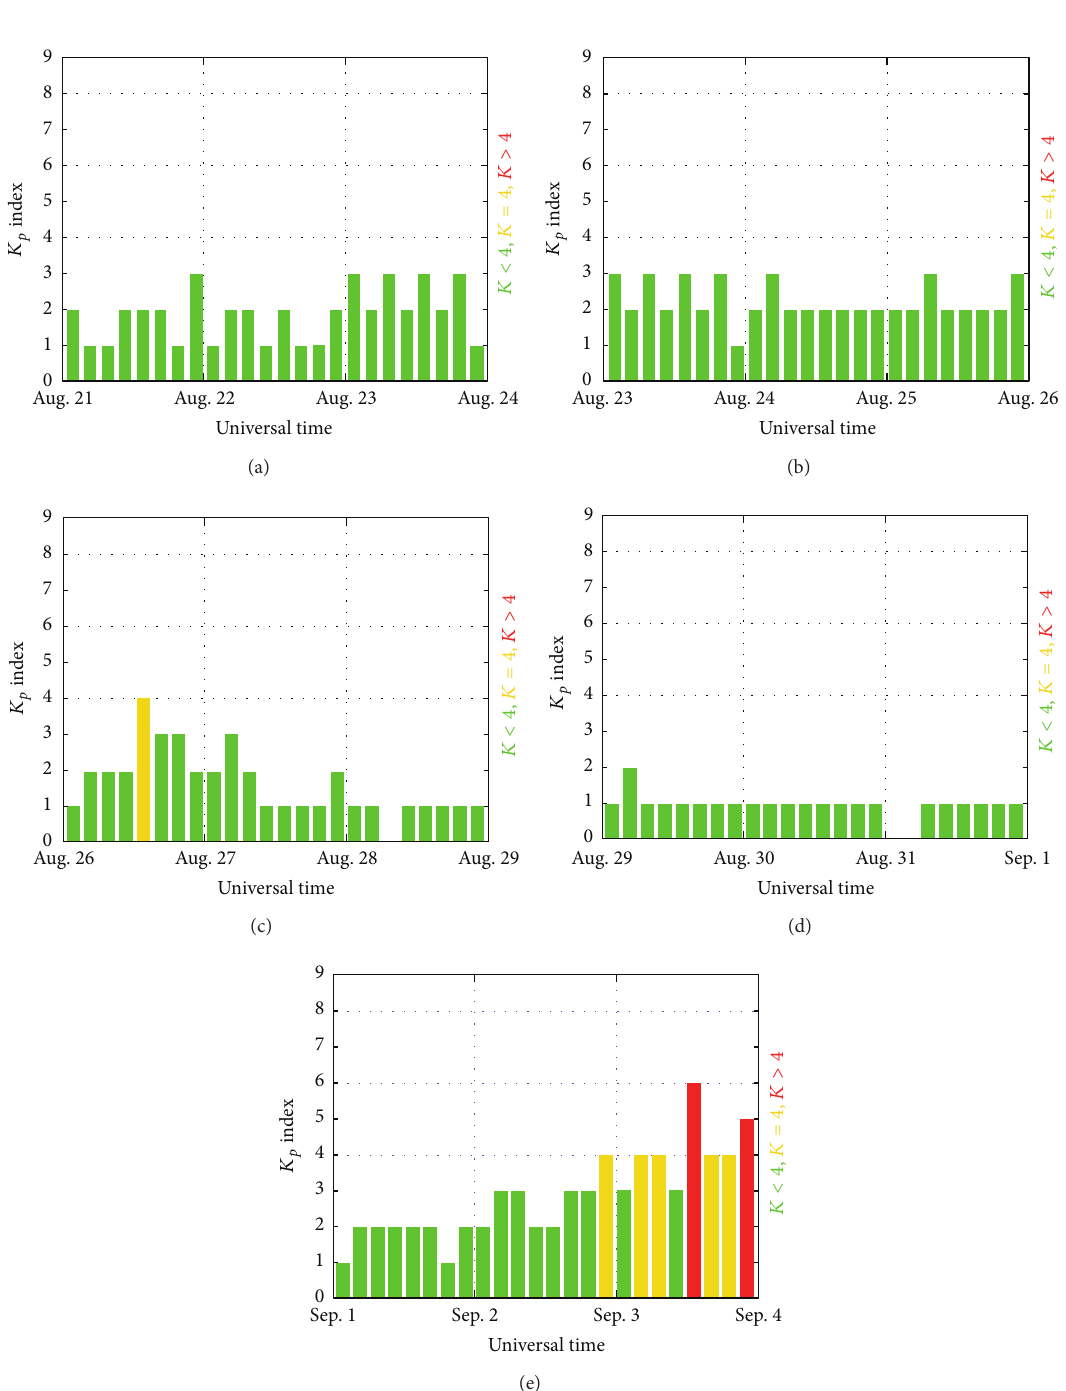
and 2DPCA, and no earthquake-related anomaly is